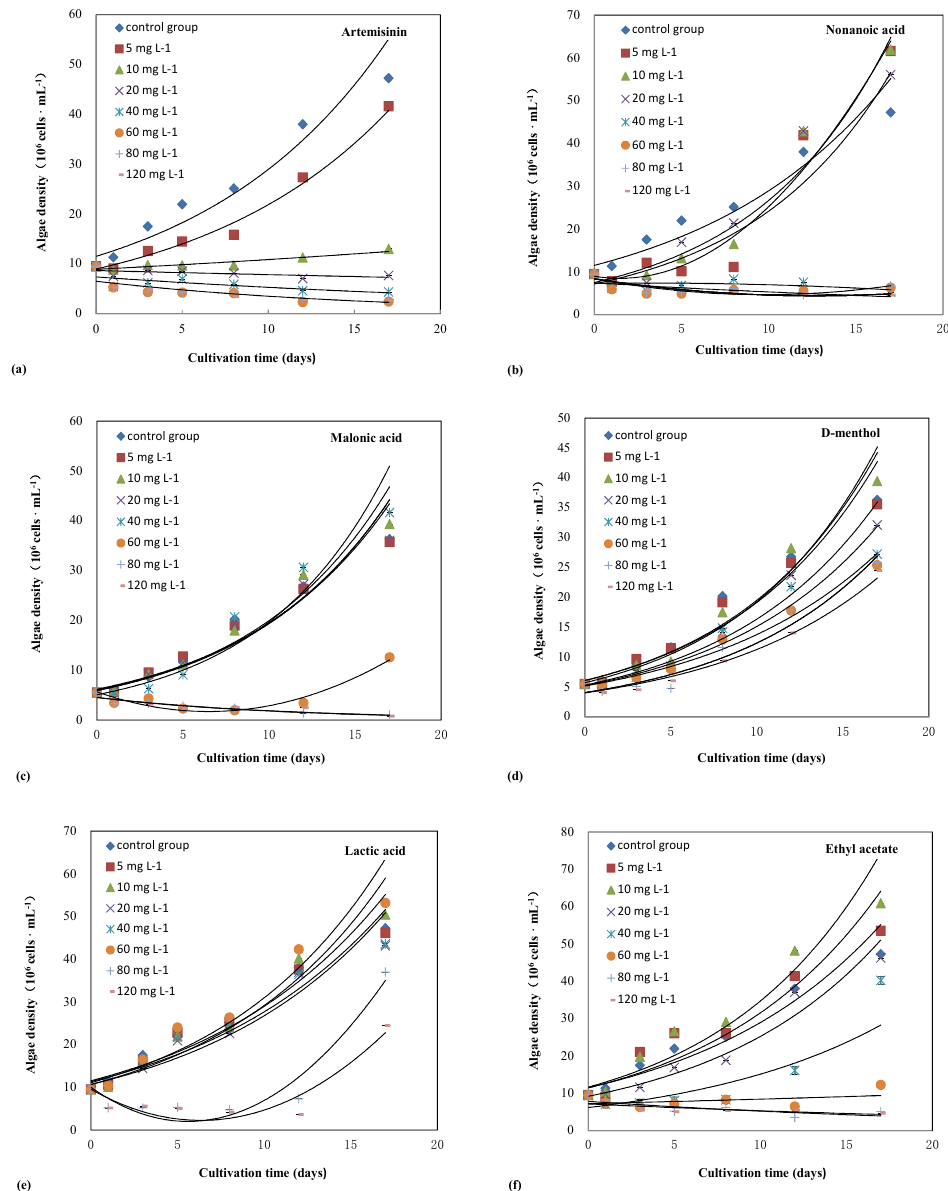
Figure 1. Cell density of Microcystis aeruginosa in different treatments. Figure 1( a )–( f ) presented algal inhibition effects in groups treated by artemisinin, nonanoic acid, malonic acid, D-menthol, lactic acid and ethyl acetate, respectively.